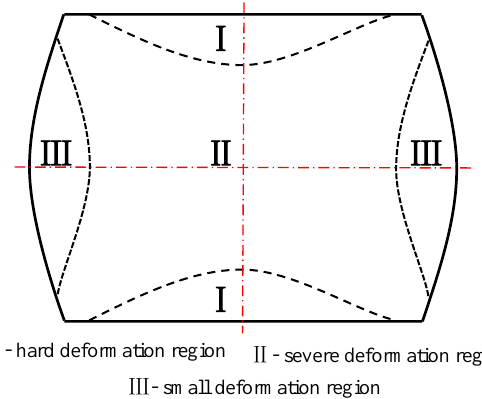
Figure 14. The schematic expression of deformation regions distribution in specimen during the simulated isothermal compression tests.